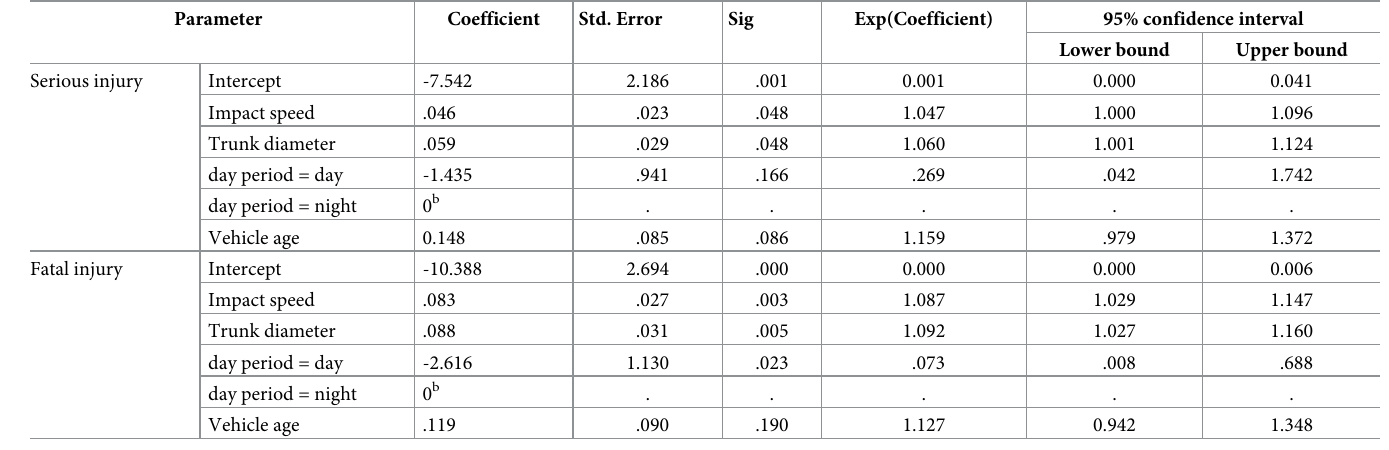
Table 7. Parameter